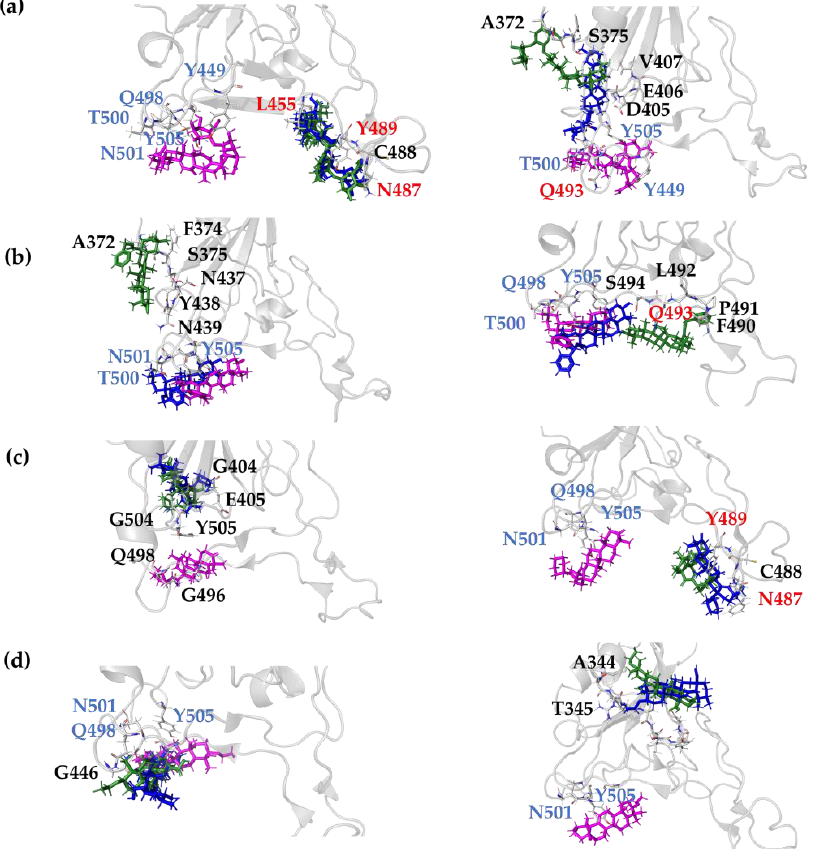
Figure 6. Trajectory snapshots at 0 ns (magenta), 50 ns (blue) and 100 ns (green) of first (left) and second (right) replica of: ( a ) GA reference molecule, ( b ) OA5 , ( c ) MA4 and ( d ) UA2 derivatives. All diagrams were constructed with PyMOL. Grey ribbons represent RBD domain while interacting residues are displayed as sticks and labeled; red labels represent the amino acids at BS1 and blue labels the amino acids at BS2.